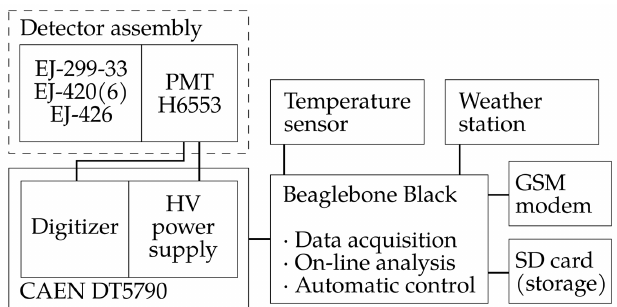
Figure 2. Block diagram of the data acquisition chain of the probe. Abbreviations: PMT, photomultiplier; HV, high voltage; GSM, protocol for data trasmission; SD, Secure Digital.